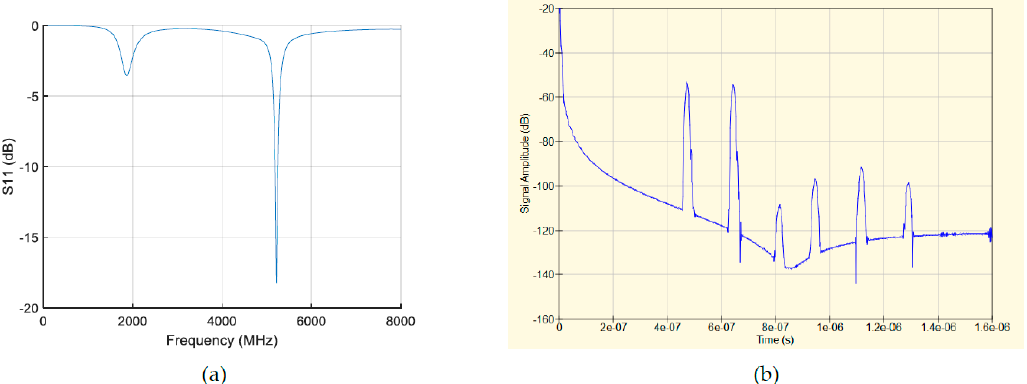
Figure 4. ( a ) S11 parameters of the antenna only. ( b ) Computed time response of a typical reflective Delay-Line in AlN/ZnO/LN, similar to the one presented in Figure 3.a. Note the expected level of the two main peaks, close to − 55